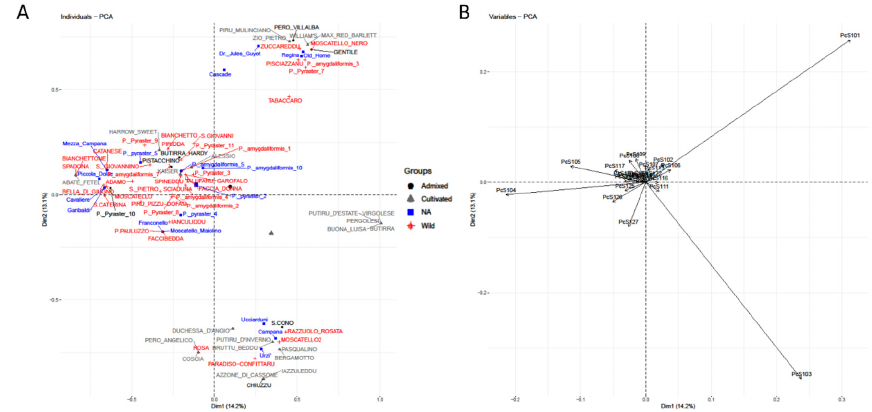
Figure 2. Principal component analysis (PCA) depicting the distribution of accessions over the first two PCs (Dim1 and Dim2) performed on the genetic data scored for the presence / absence of each S-allele. ( A ) PCA biplot: different colors indicate the subpopulations detected with structure analysis in Bennici et al. (2018) [17]: “wild” (red); “cultivated” (blue); “admixed” (black); not available (gray). ( B ) Loading projections of the variables employed.